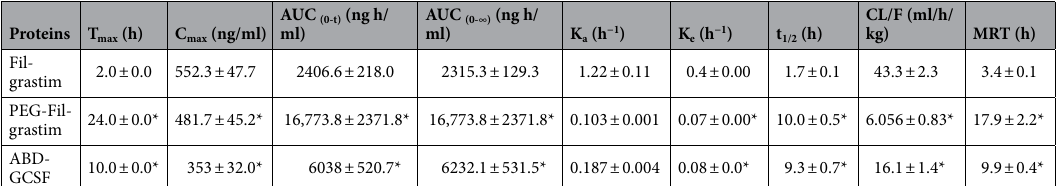
Table 1. Major pharmacokinetic parameters of administered ABD-GCSF in a neutropenic rat model. Data is represented as the means ± SD of 5 rats/group. T max , Time to reach the peak plasma concentration; t 1/2 , Elimination half-life; C max , Maximum observed plasma concentration; K e , Elimination rate constant; CL/F , Apparent total clearance; AUC , Area under the serum concentration–time curve; MRT Mean residence time. *P < 0.05 in comparison with the Filgrastim